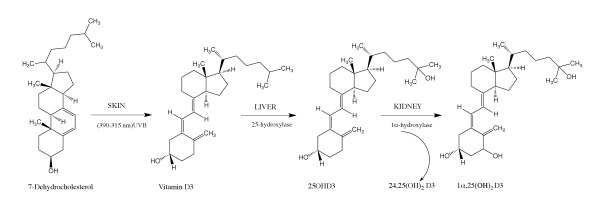
Metabolic pathways for Vitamin D3 [8-10].